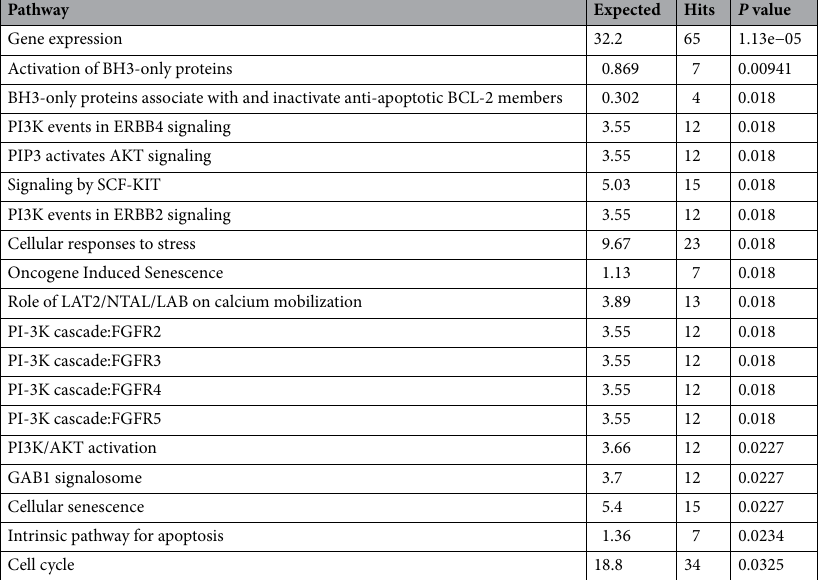
Table 1. Enriched pathways for oncomirs in the complete response